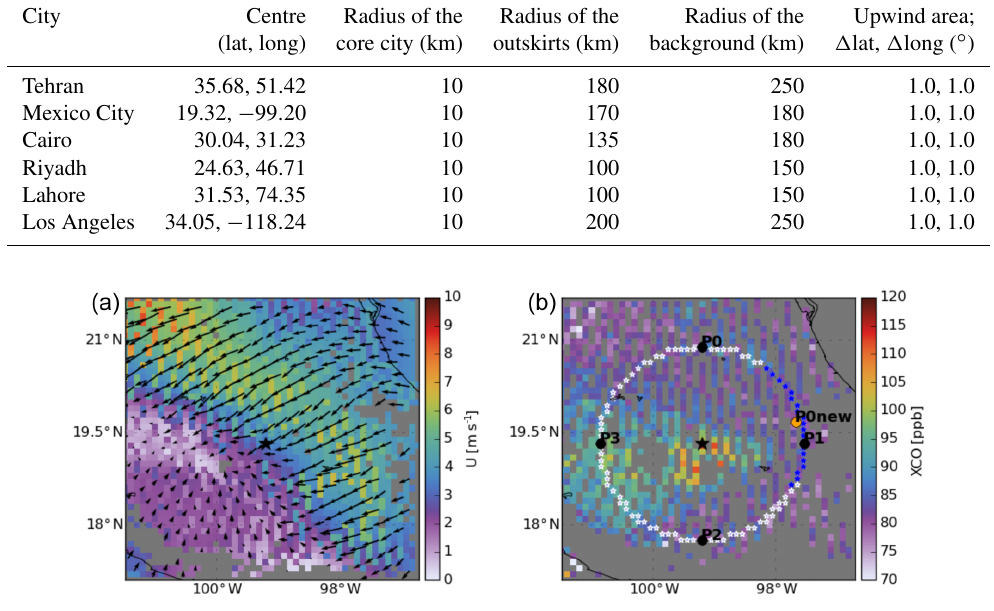
Figure 1. Average wind speed and direction from the surface to 200m from ERA-Interim at the TROPOMI overpass time (a) , and the TROPOMI-derived total column CO over Mexico City (b) for 4 June 2018. The black star represents the centre of the city. In the right panel, the white circle is the background area for Mexico City, and the blue section represents the upwind background area that we selected depending upon the wind direction ( θ ) in the core city area. P0, P1, P2, and P3 are the points where the northern, eastern, western, and southern wind directions intersect with the background area. P0 new is the new point generated by rotating P0 with θ in reference to the city